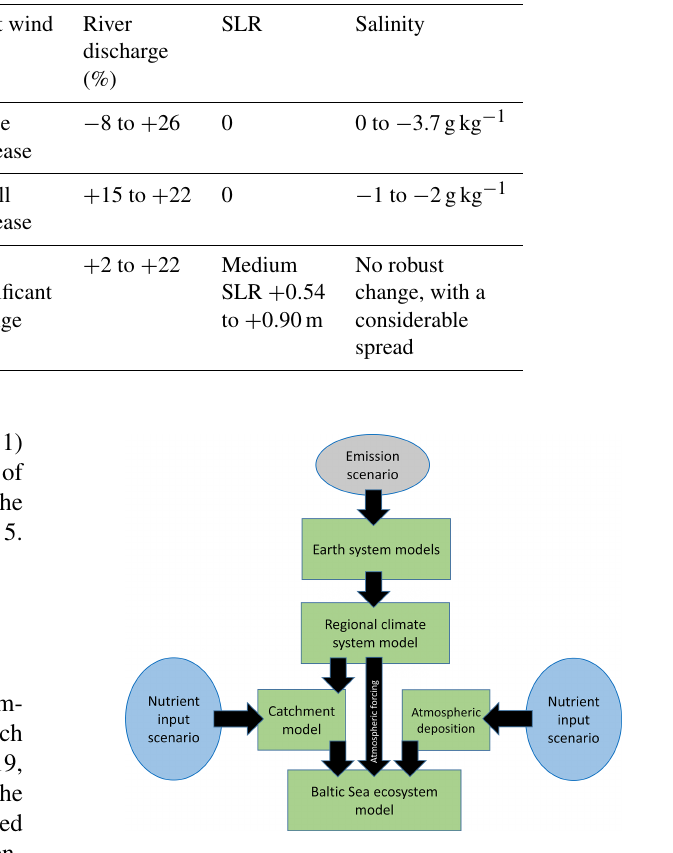
Figure 2. Dynamical downscaling approach for the Baltic Sea re- gion. The models for the various components of the Earth system are explained in Sect. 2. (Source: Meier et al.,